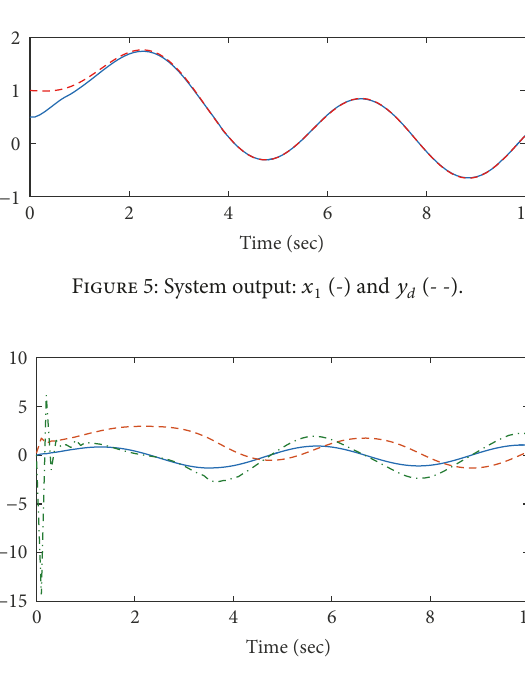
Figure 6: State variables 𝑥 2 (-), 𝑥 3 (- -), 𝑥 4 (-.-).